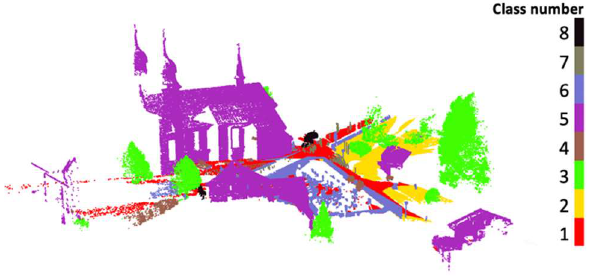
Figure 2. Ground truth labels of the test dataset Classification using the PointNet++ Multi Scale Grouping frame- work results in a mIoU of 0.84 compared to 0.94 for feature set C.